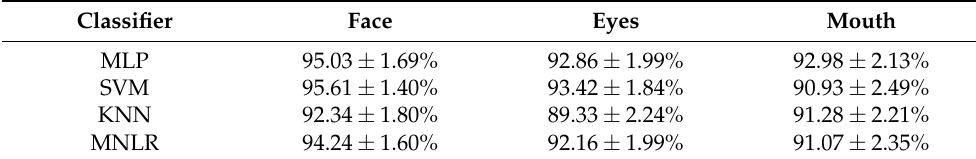
Table 4. Results of the detection of palsy regions on the criteria of accuracy.